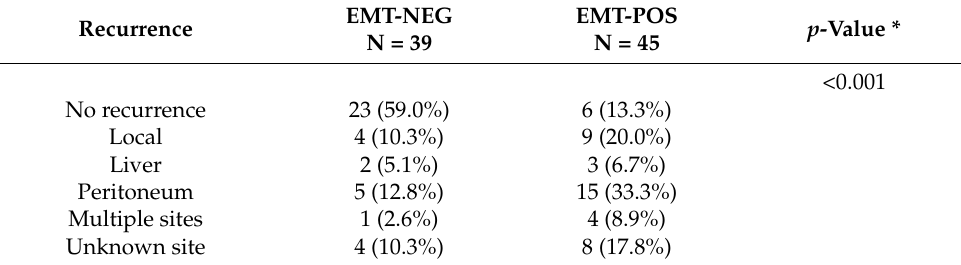
Table 3. Tumor recurrence after surgery according to EMT